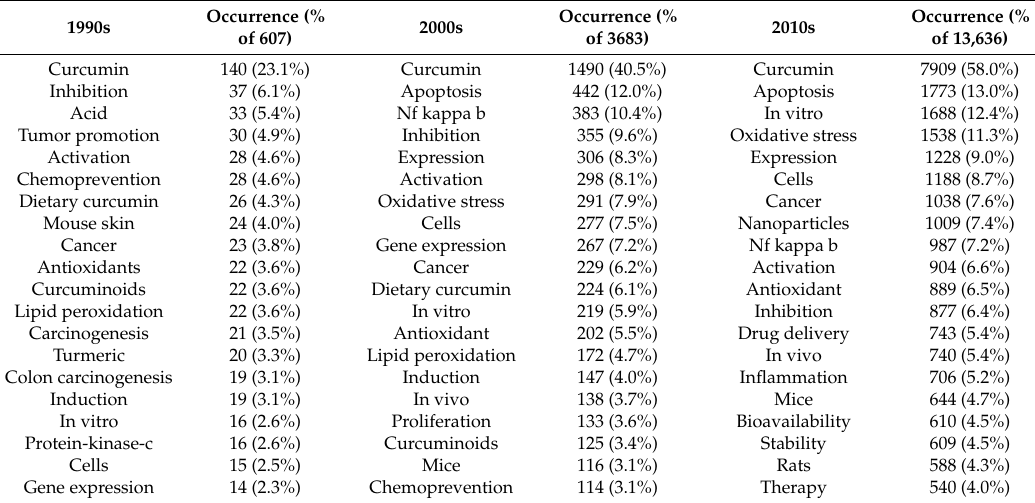
Table 4. The top 20 recurring keywords in each decade.